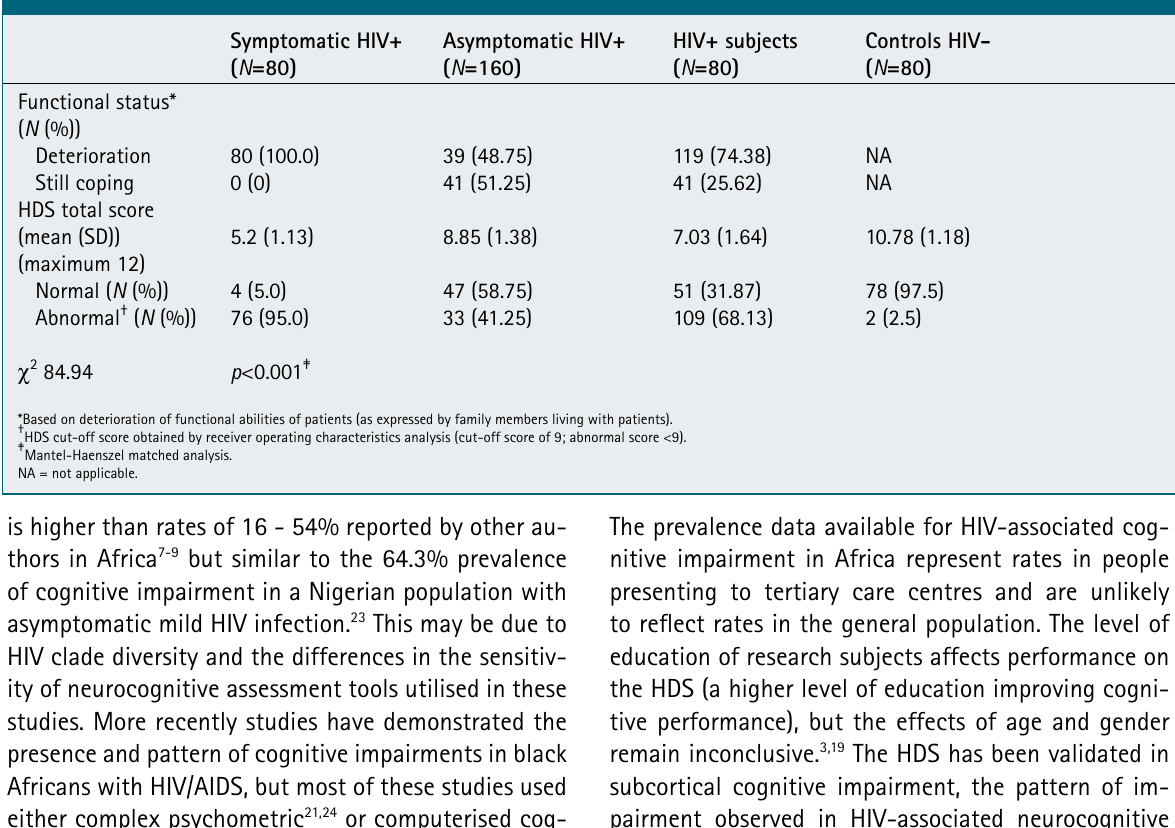
taBle V. FUnctional anD cognitiVe StatUS oF SUBJectS anD HDS